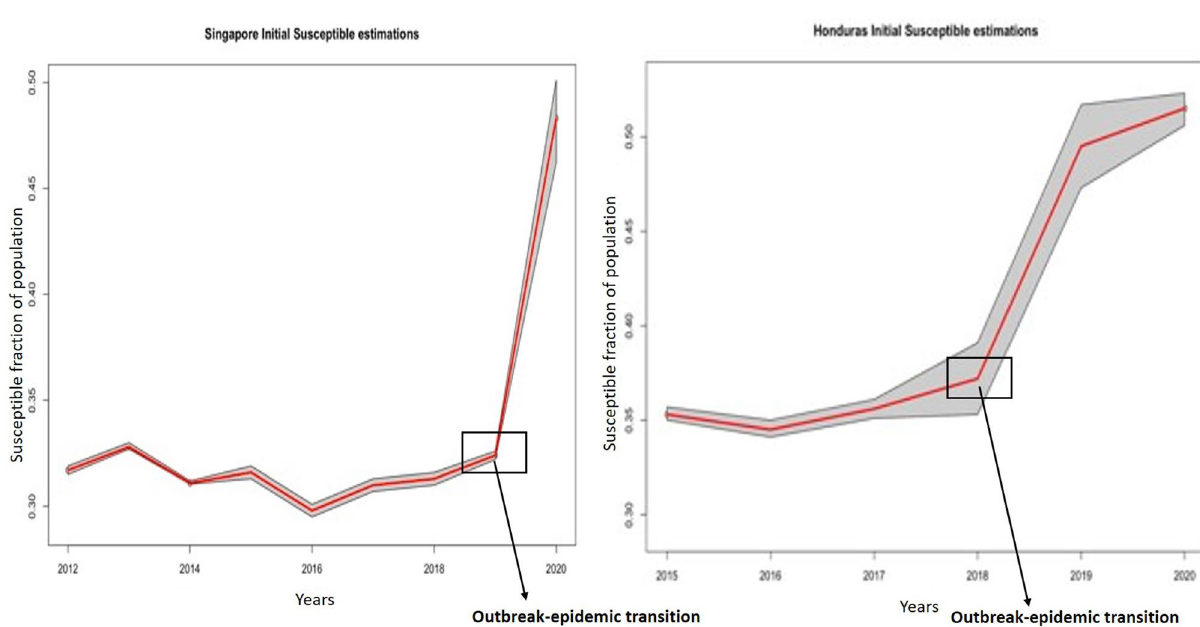
Figure 1. Trend of susceptible fractions by year for Singapore and Honduras. Red line represents point estimates and gray region is 95% confidence interval. The outbreak to epidemic transition is denoted as the position from where steep increase in cases occur, which was 2019–2020 for Singapore and 2018–2019 for